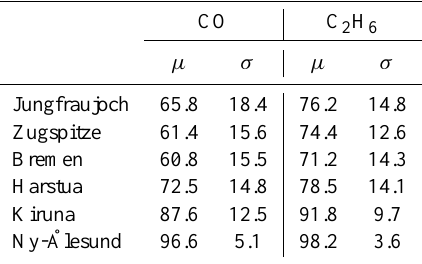
Table 5. Average ( µ ) and standard deviation ( σ) contribution from the boundary conditions (BIC) for the European-scale EMEP model, expressed in percent